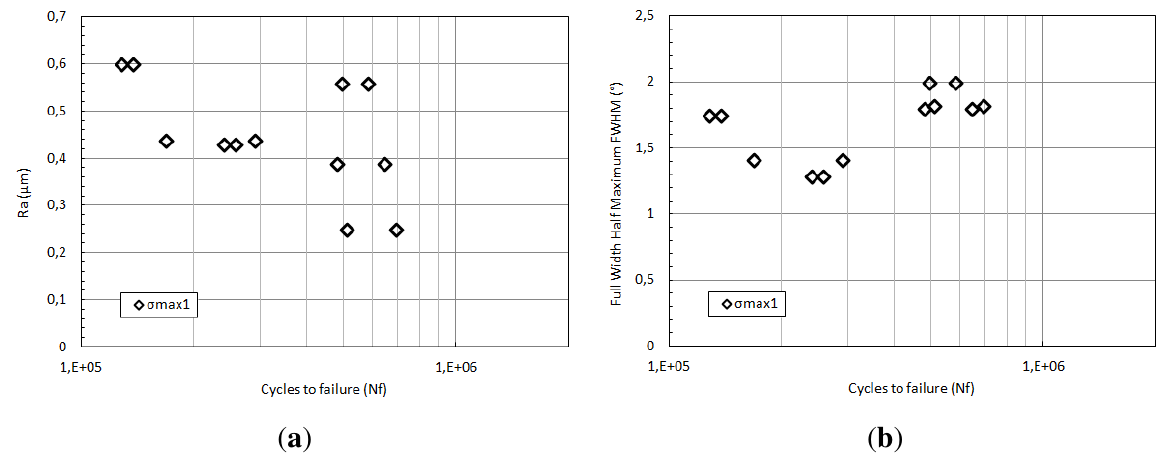
Figure 6. Roughness ( a ) and chord width ( b ) depending on the fatigue life time to σ